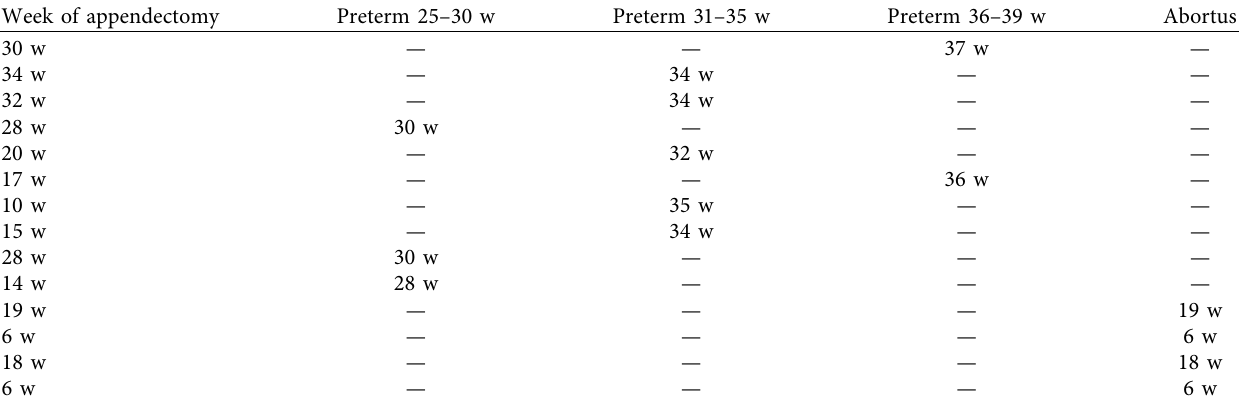
Table 3: Relationship between the appendectomy week in pregnancy and the weeks of observing preterm-abortion status. Week of appendectomy